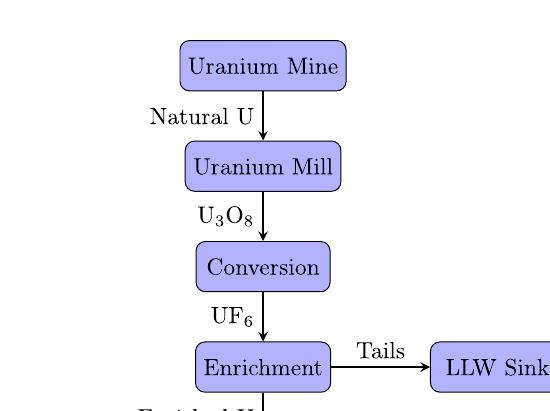
Fig. 2. Energy supplied by LWRs compared to the number of LWRs deployed in Scenario